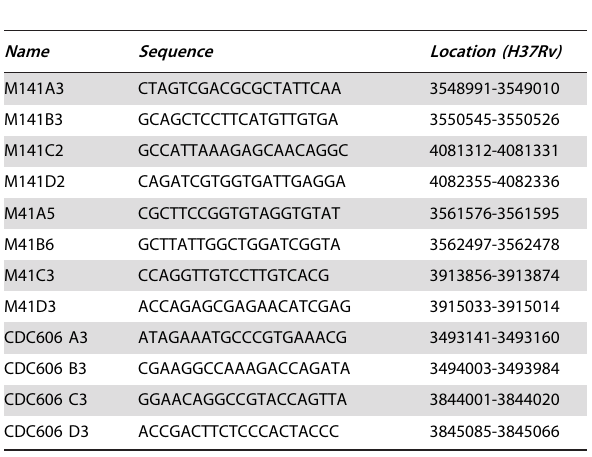
Table 3. Primer locations for PCR